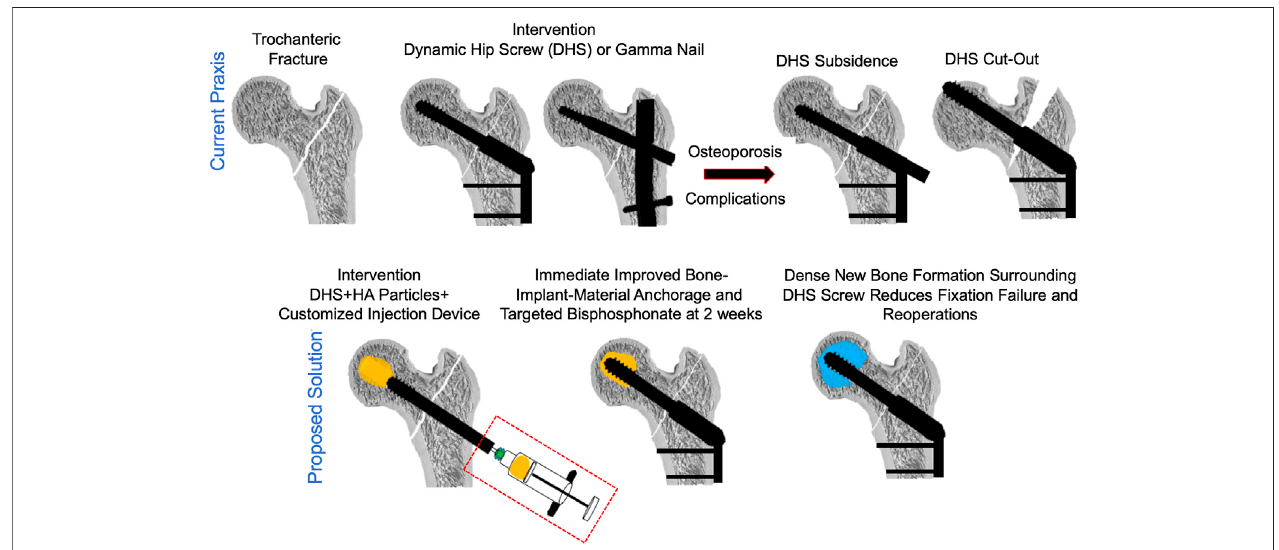
FIGURE2| Aschematicindicatingthecurrentpraxisusedforthesurgicalmanagementofpertrochantericfractures(top)andtheproposedsolutionofaugmenting the lag-screw with a CaS/HA biomaterial to reduce fracture fi xation device failure (bottom).